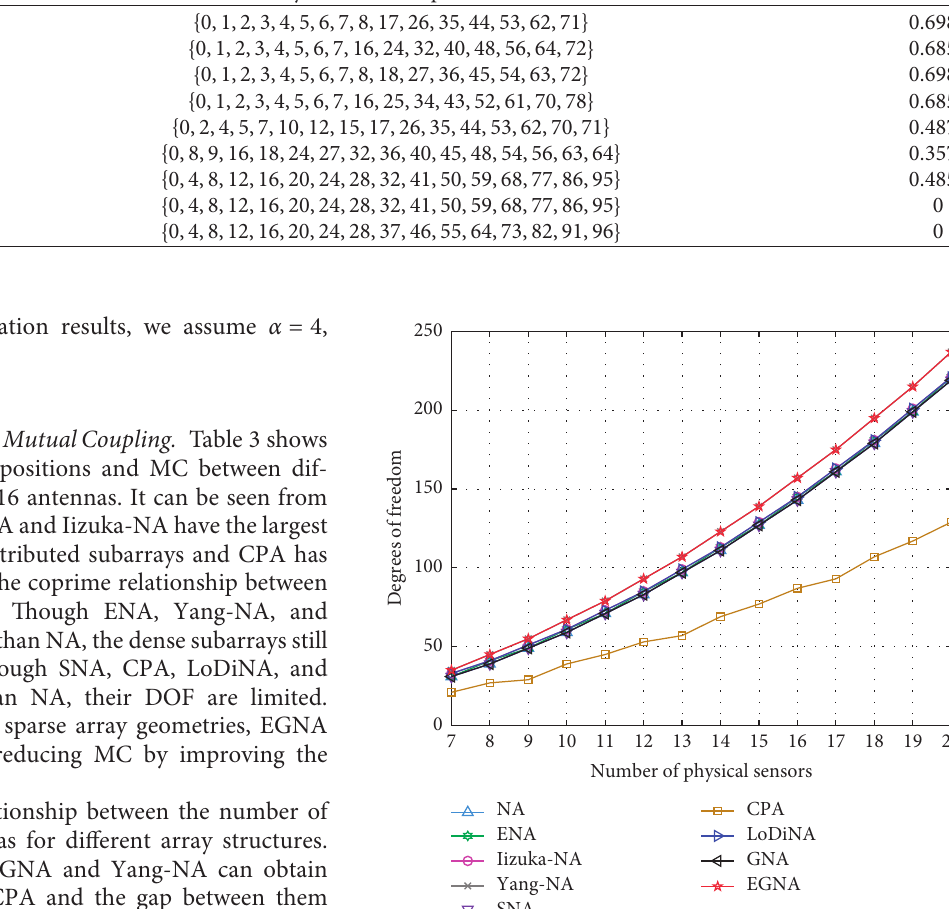
Figure 7: DOF versus the number of physical